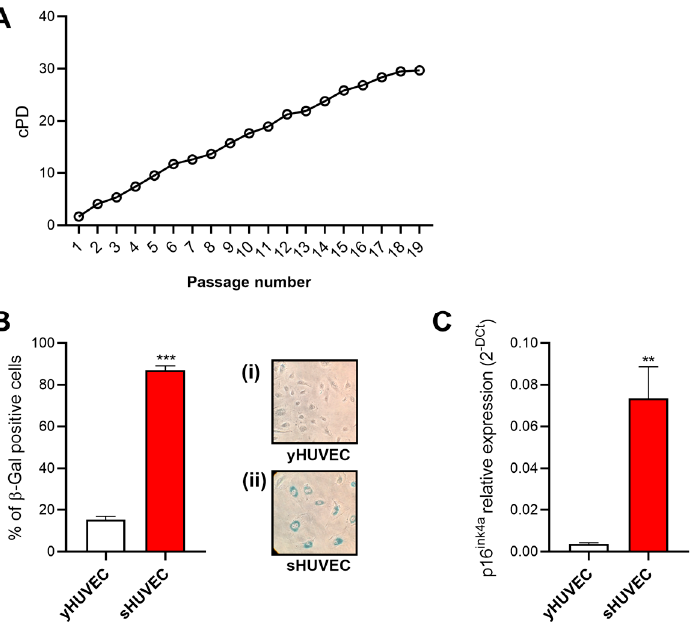
Figure 2. Replicative senescence in HUVECs. Characterization of sHUVEC by a cumulative population doubling curve ( A ), β -Gal activity ( B ) in yHUVEC (i) and sHUVEC (ii) and p16ink4a expression level ( C ). The results are expressed as mean ± SD from three independent biological replicates. **, p < 0.01; ***, p < 0.001.